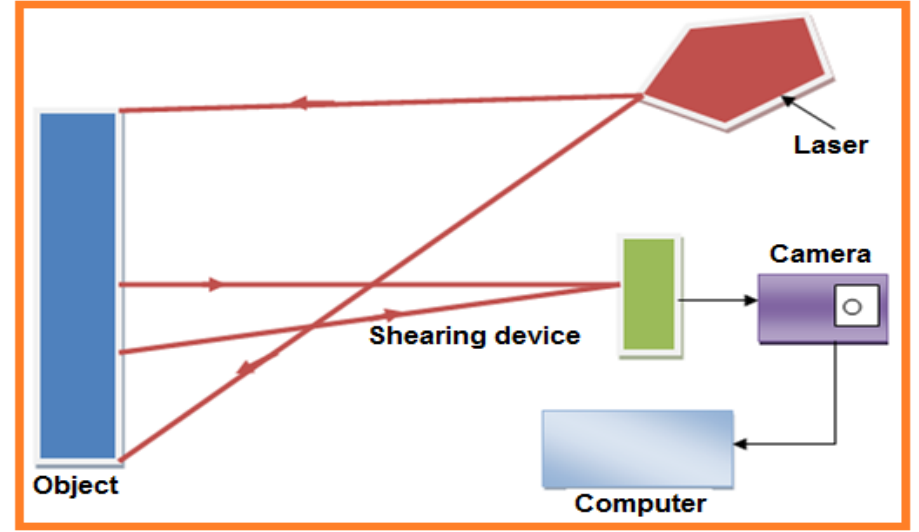
Figure 6. Line diagram of digital shearography for detection of cracks using laser point source.